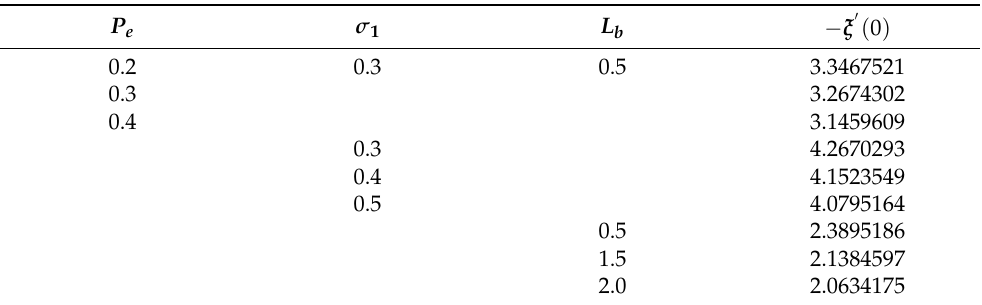
Table 6. The effect on the motile Nn x Re − 1/2 x = − ξ (cid:48) ( 0 ) with the microorganism of different physical